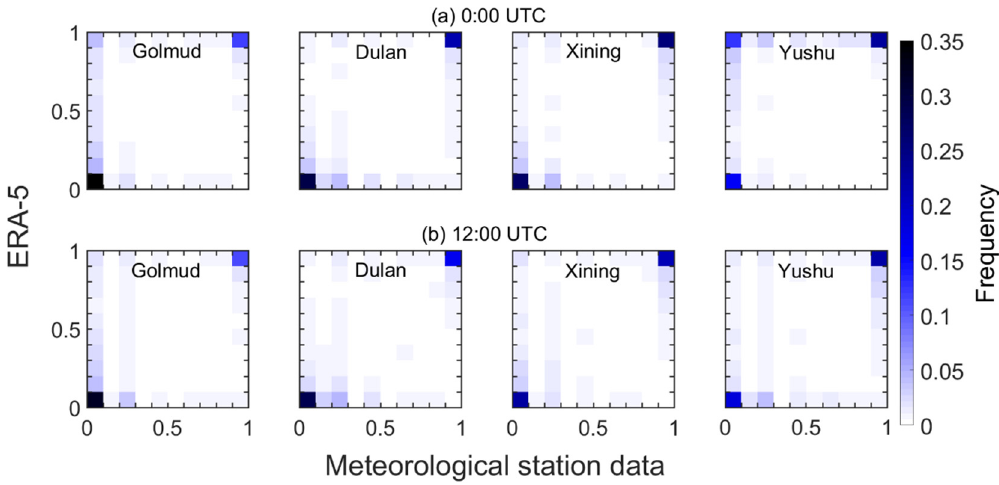
Figure 6. Total cloud cover frequency diagram of ERA-5 and Meteorological station data. ( a ) At 0:00 UTC, the coincidence frequency of the total cloud cover at each station. ( b ) At 12:00 UTC, the coincidence frequency of the total cloud cover at each station.